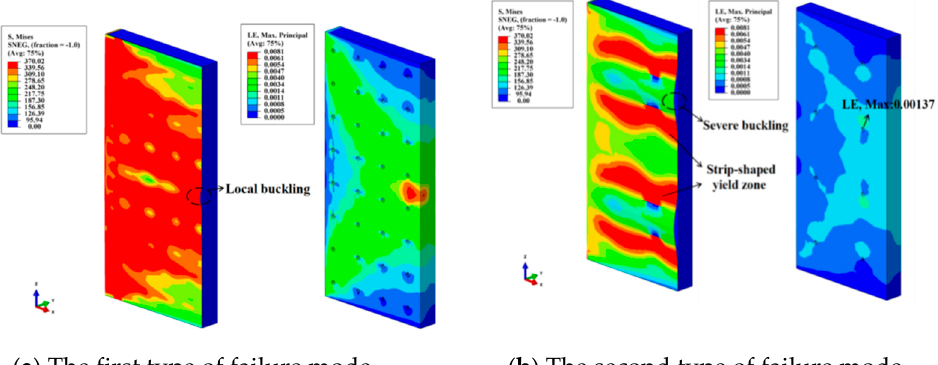
Figure 10. Two failure modes of the SDC walls (deformation scale factor = 5.0).